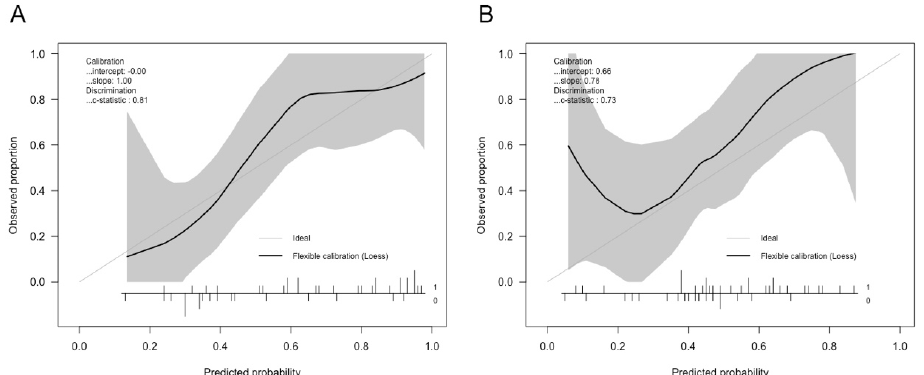
Figure 3. Calibration plot of HU feature-based models in discriminating intracranial hypertension: ( A ) calibration plot of logistic regression HU feature-based model; ( B ) calibration plot of regularized version of the model.